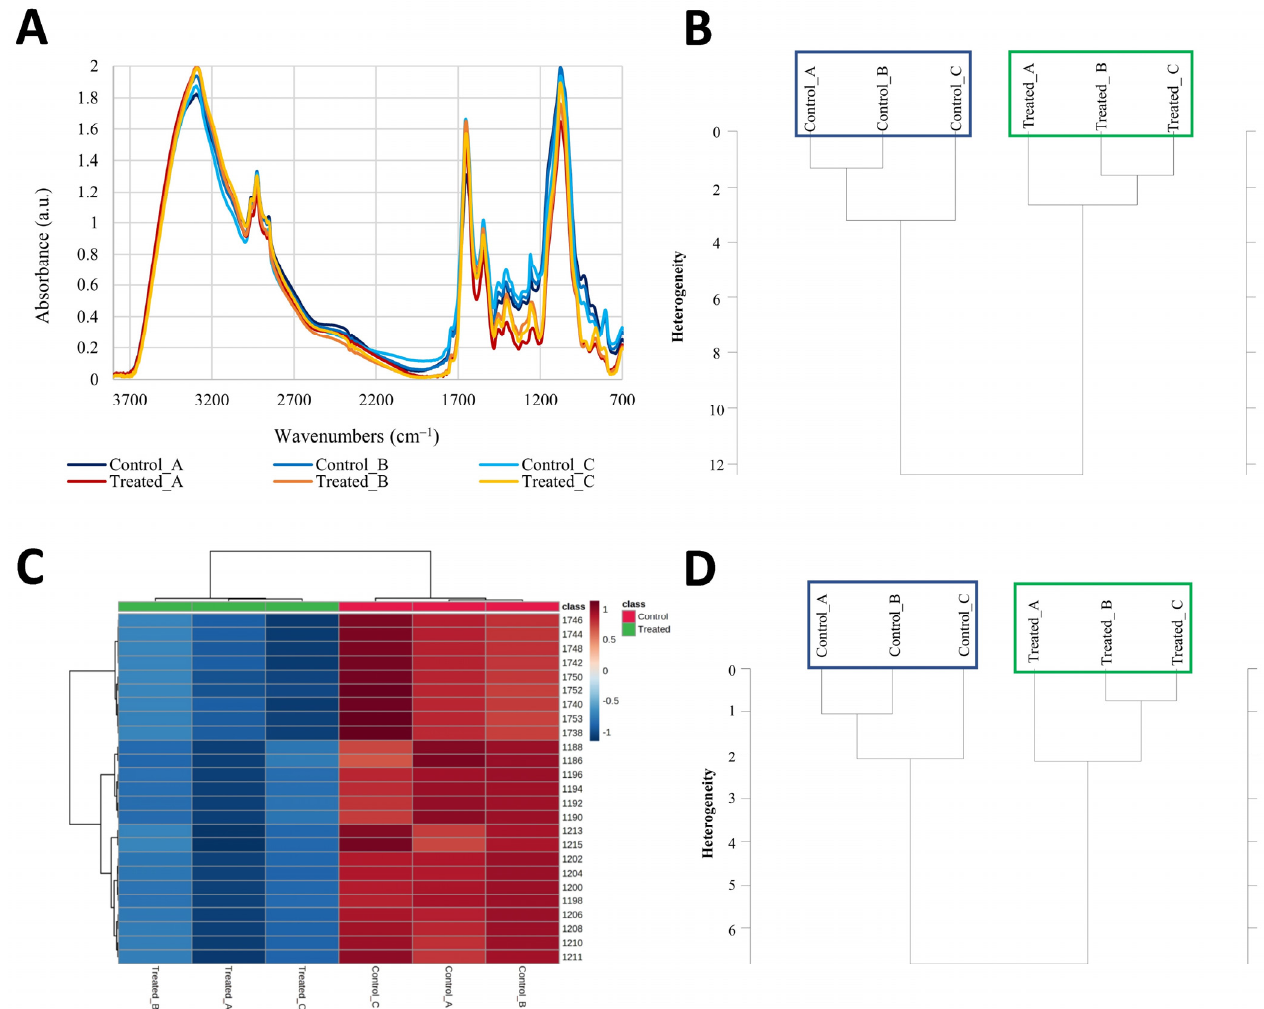
Figure 2. Representative IR spectra, Hierarchical Cluster Analysis (HCA) and heatmap of the top significantly altered region in IR spectra of control and ZA-treated biofilms. ( Panel A ): Representative average IR spectra of control (blue-shaded) and treated (red-shaded) biofilm samples; ( Panel B ): HCA carried out on whole raw spectra. ( Panel C ): Heatmap highlighting the most altered FTIR regions; ( Panel D ): HCA carried out on combined W 2 and W 3 regions.